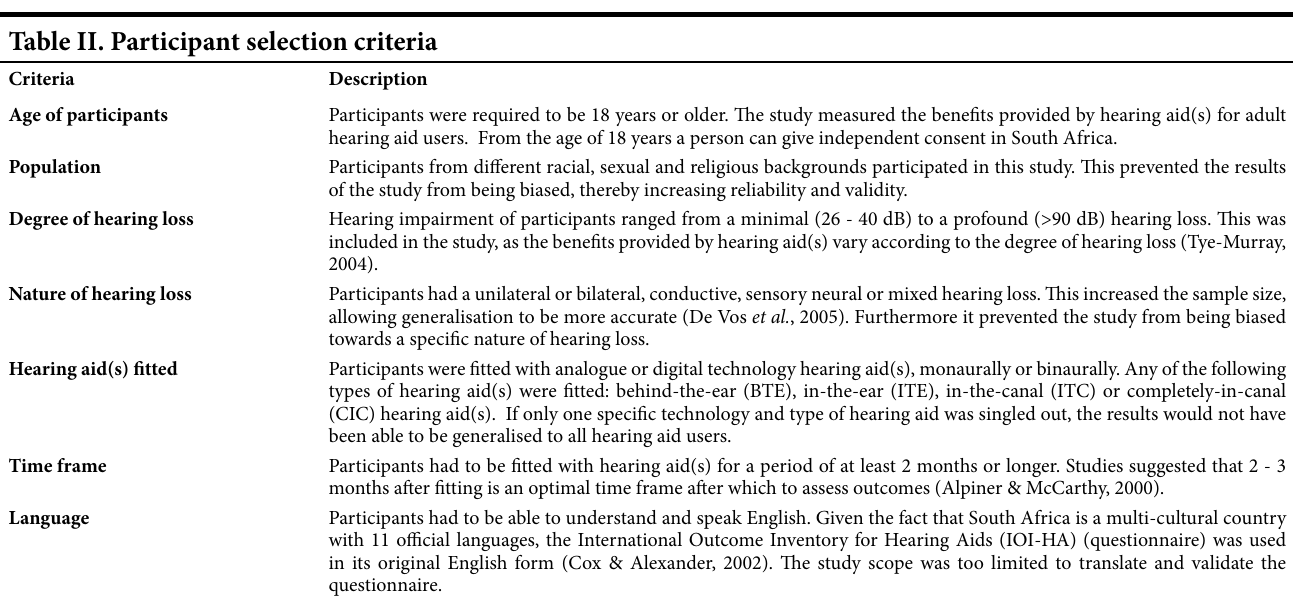
table II. Participant selection